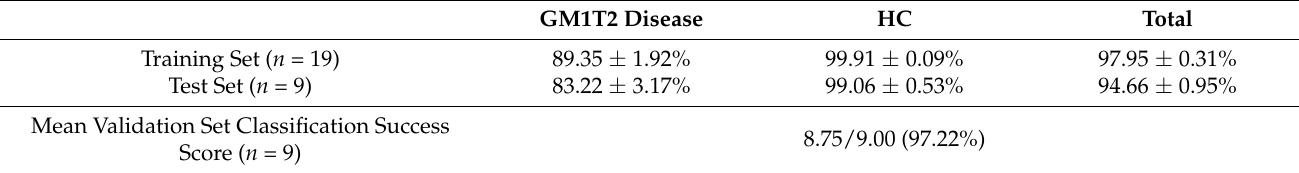
Table 5. Mean ± SEM predictive accuracies for the training, test and total sets in a PLS-DA-based validation model involving a ‘hold-out’ sample of n = 9 plasma samples. The mean validation set classification success score is also